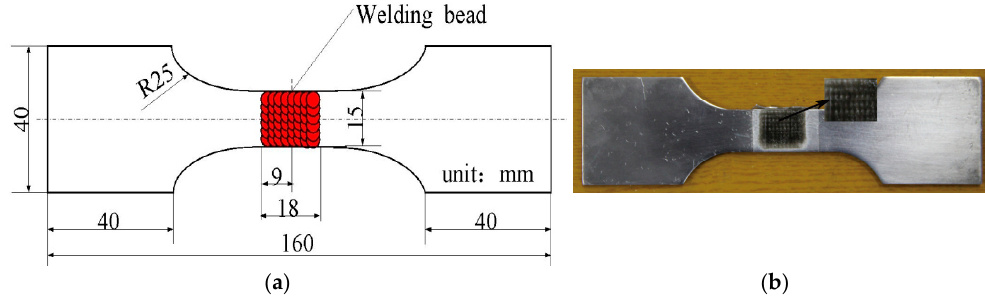
Figure 1. ( a ) Schematic of the specimen treated with LSP assisted by DSA; ( b ) the specimen treated with LSP assisted by DSA. with LSP assisted by